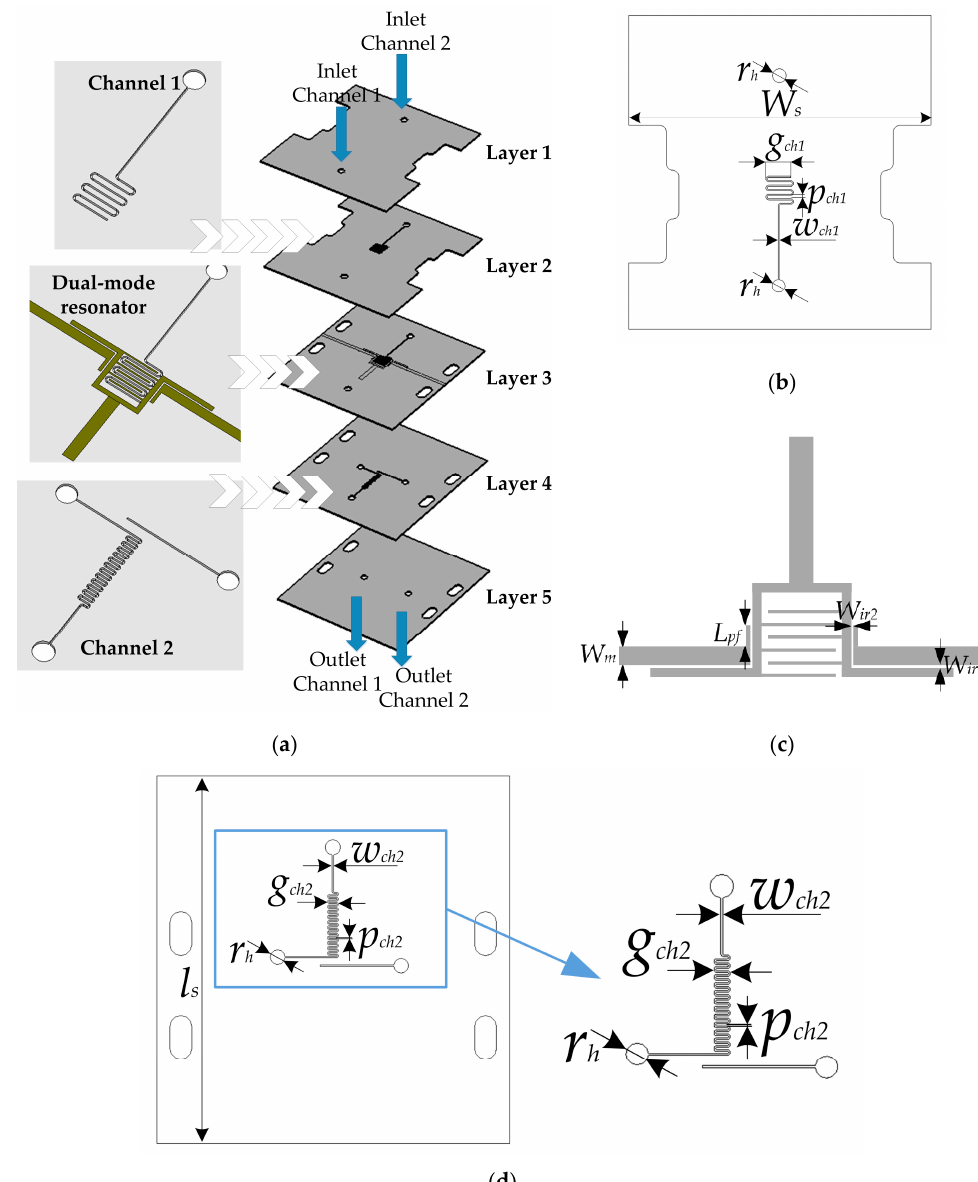
Figure 3. ( a ) 3D layout of the proposed sensor; ( b ) 2D layout of layer 2; ( c ) 2D layout of layer 3; ( d ) 2D layout of layer 4.